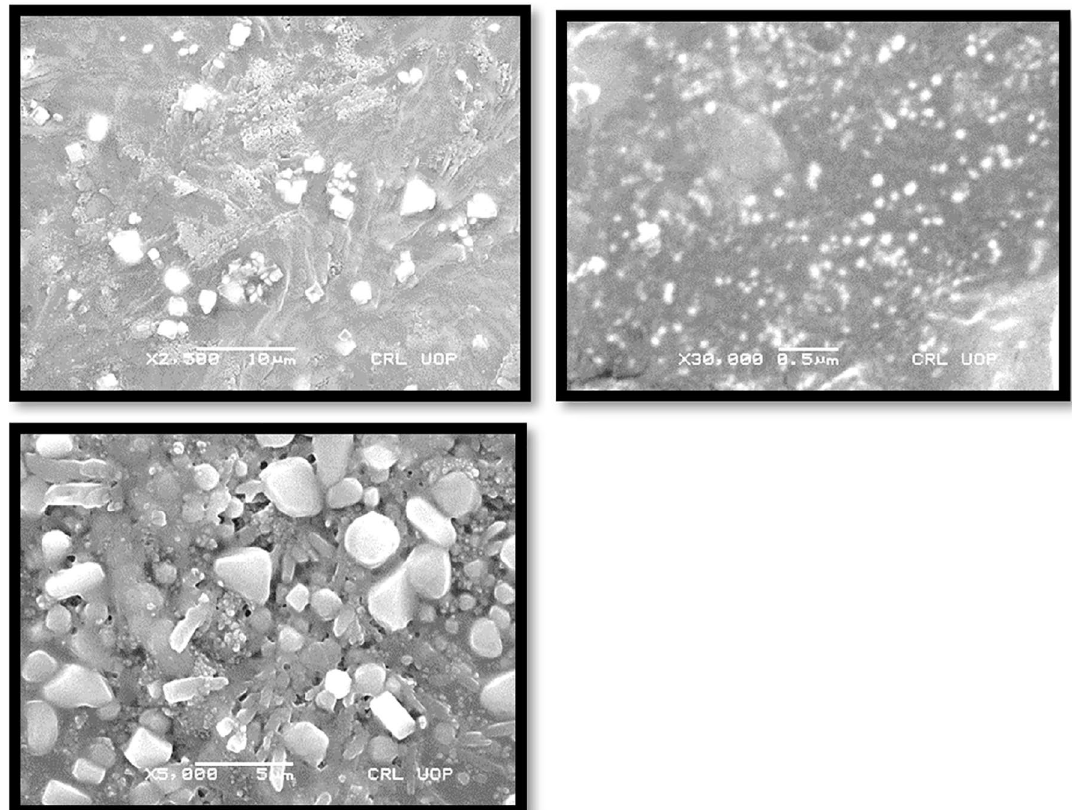
Figure 5. Microscopic evaluation of optimized Glu-loaded transfersome (S4 formulation).